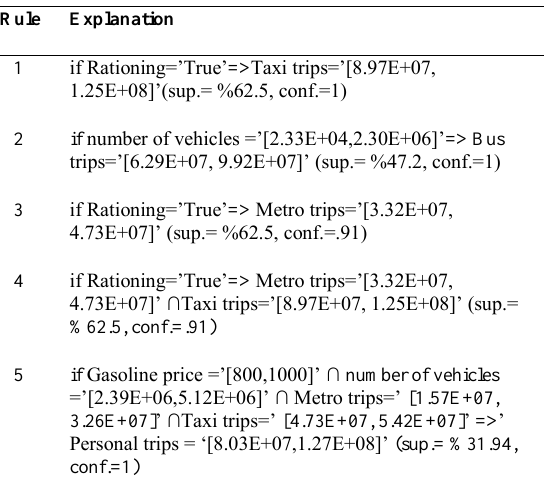
Table 7. Extracted rules for high gasoline consumption.